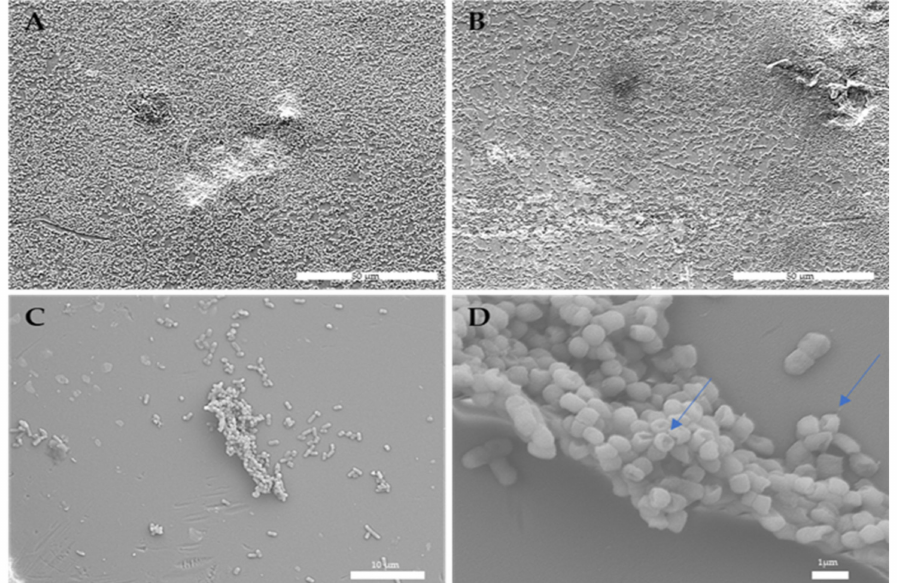
Figure 8. Morphological changes in representative strain K. pneumoniae NCTC 13442 biofilm biomass and bacterial cells after ozone treatment. Recess areas in the biofilm topology were observed ( A – C ), as well as bacterial cell surface alteration ( D ) (arrowhead).